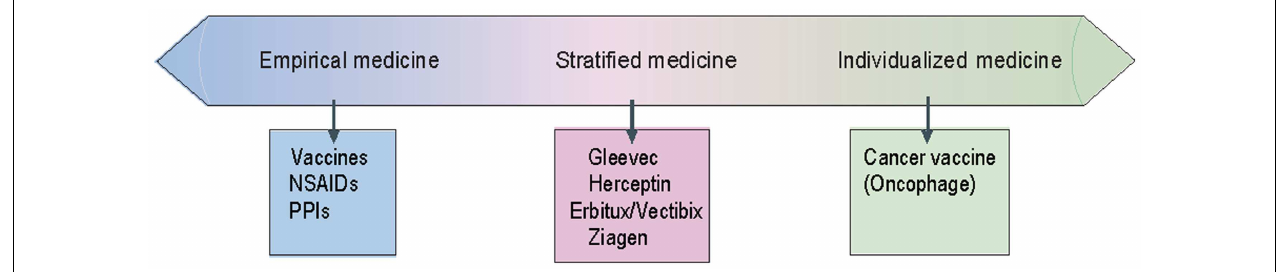
Frontiers in Pharmacology | Pharmaceutical Medicine and Outcomes